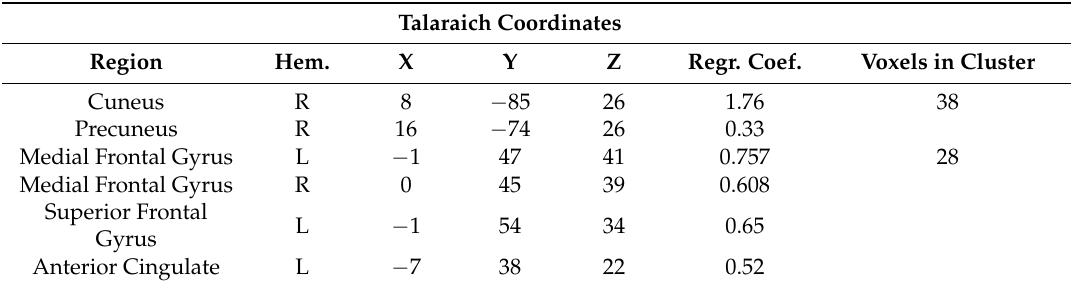
Table 4. Regions of significantly greater activity in caffeine non-consumers compared to caffeine consumers while judging the pleasantness of caffeine.